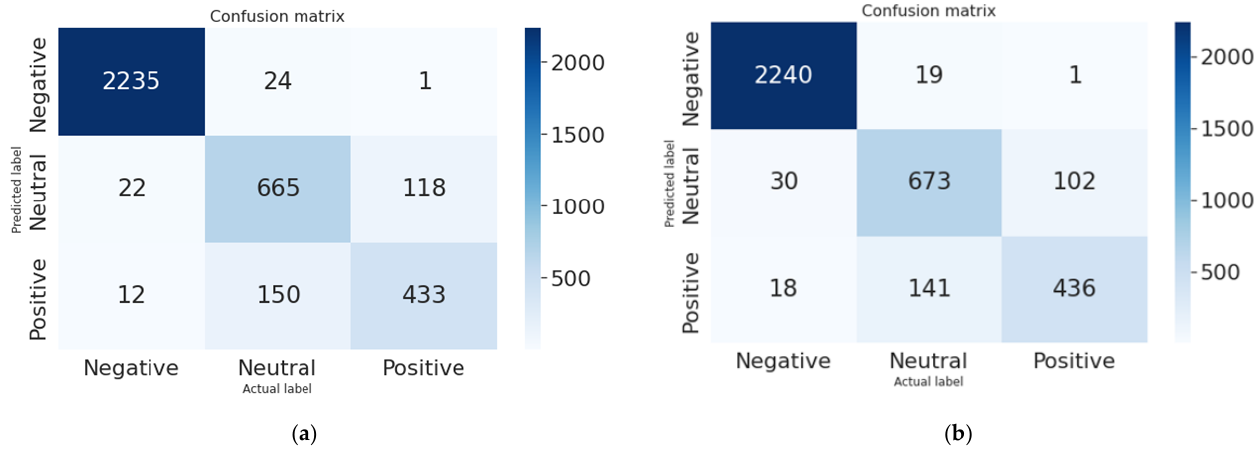
Figure 5. ( a ) Confusion matrix–XGB classifier with best accuracy ( b ) Confusion matrix–RF classifier with second best accuracy. with second best